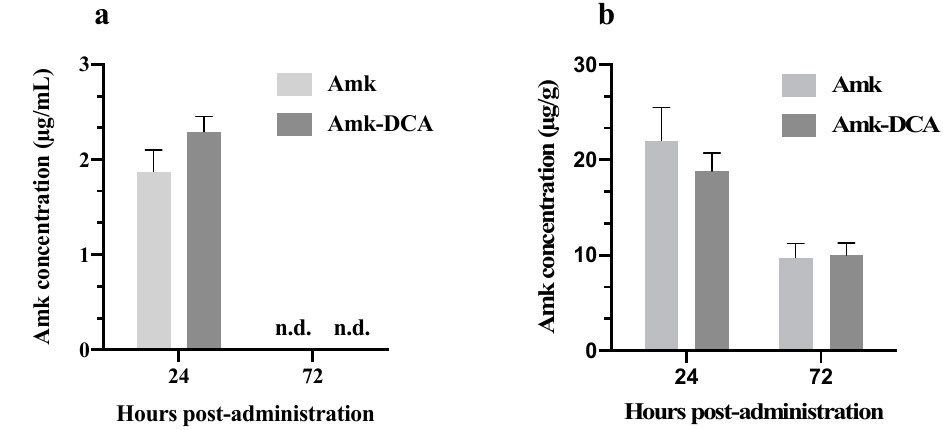
Figure 2. Drug levels ( a ) in blood and ( b ) lung tissue, measured at 24 h and 72 h after two repeated i.n. administrations at 2 mg/kg dose (mean ± standard deviation, n = 2), n.d. not detected at the retention time of standard.